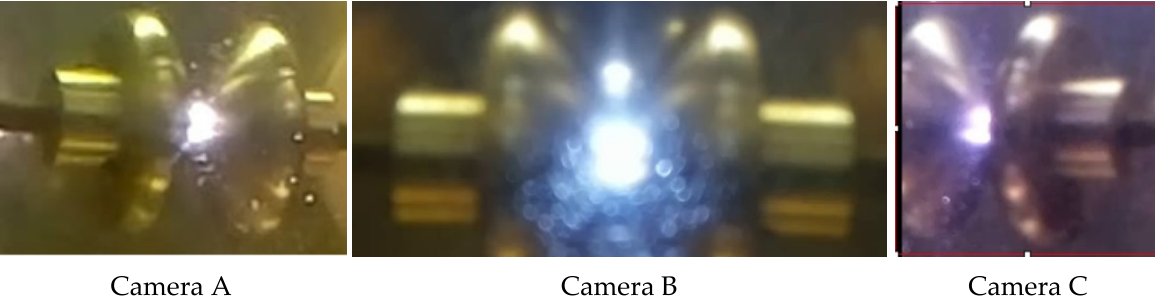
Figure 12 shows the capture of the electric arc recorded by cameras A, B and C, from